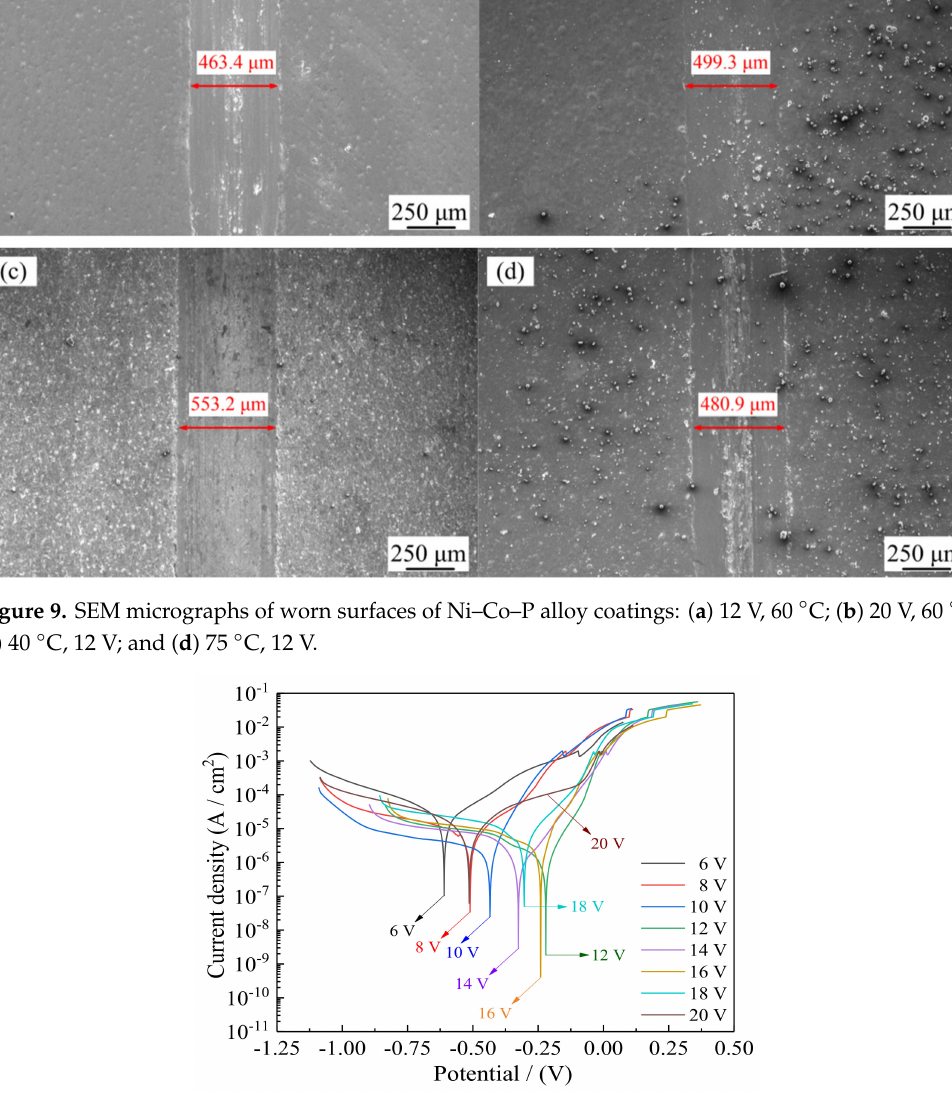
Figure 10. E ff ect of jet voltage on polarization curves of Ni–Co–P alloy coatings in artificial seawater. Table 6. The corrosion potential ( E corr ), corrosion current density ( I corr ), and corrosion rate obtained from the Figure